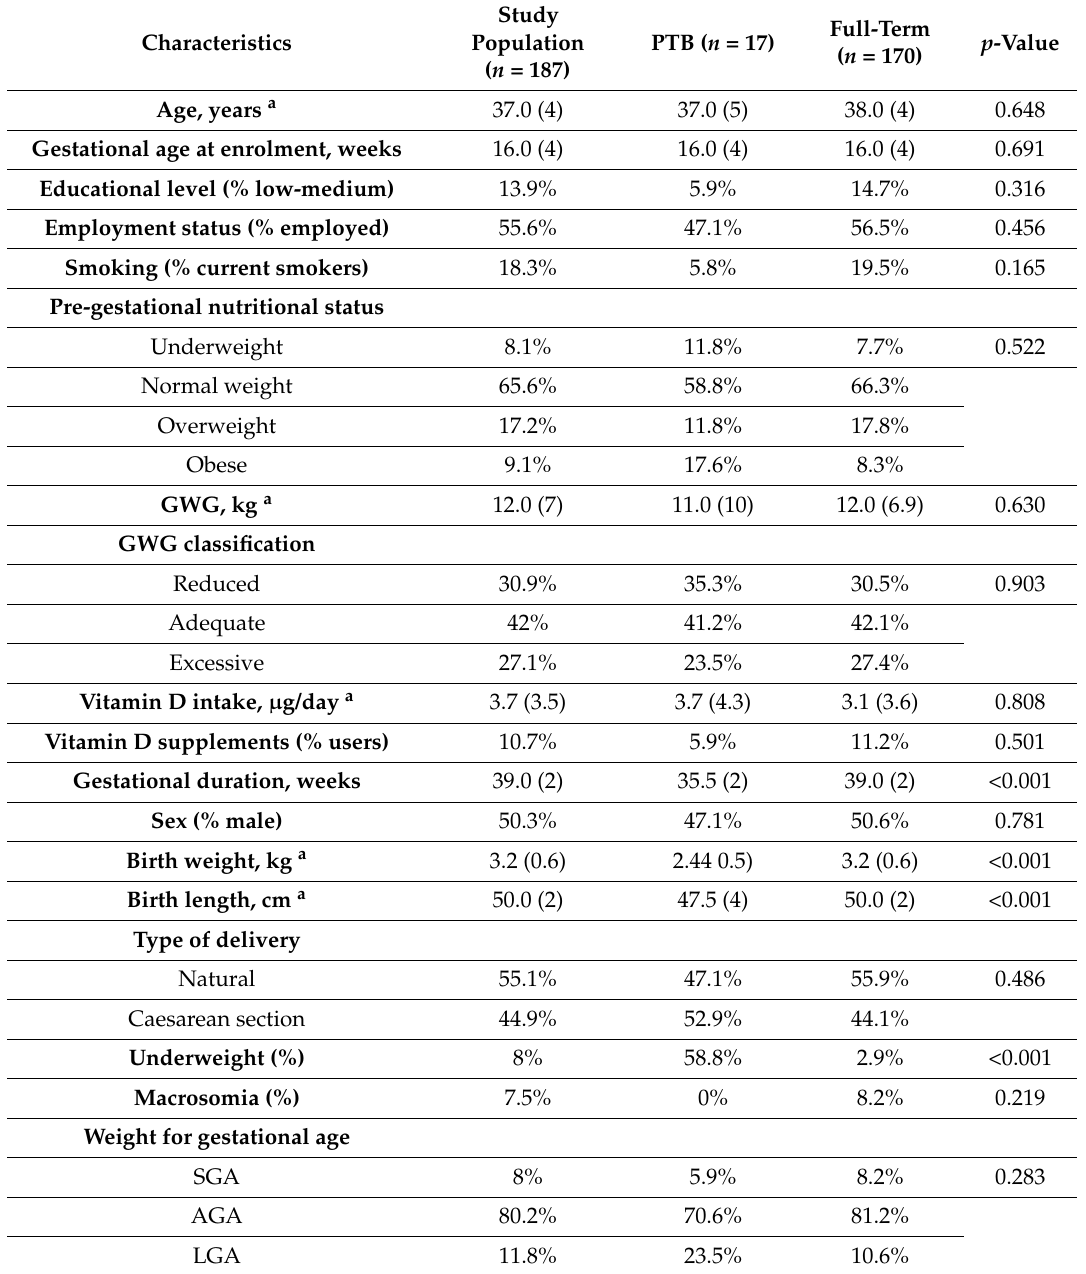
Table 1. Population characteristics and comparison between preterm and full-term